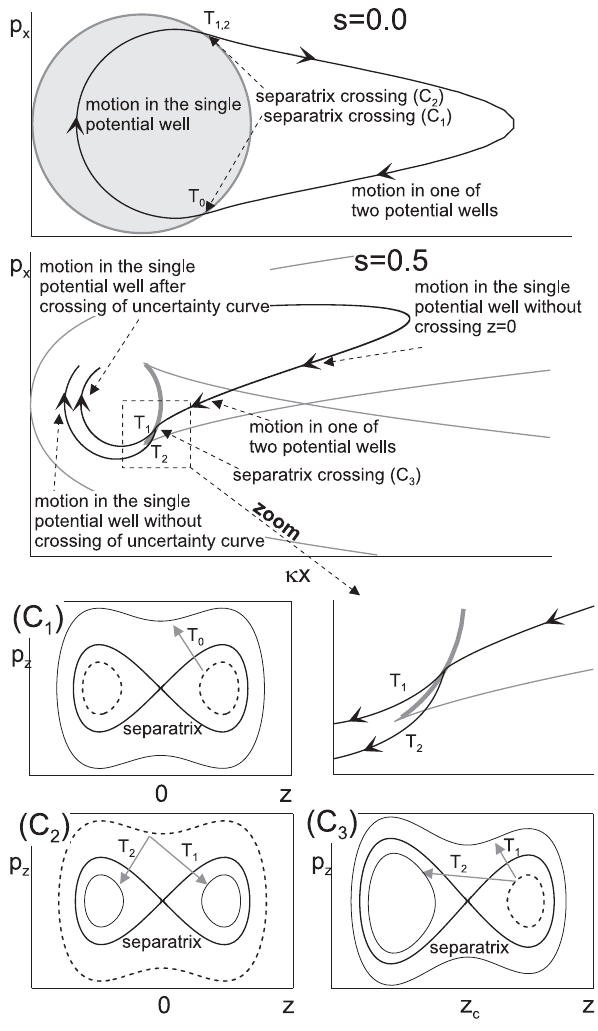
Fig. 4. Schemes of particle trajectories in systems with s = 0 and with s = 0 . 5 are shown in the phase plane (κx,p x ) . Fragment of (κx,p x ) plane with trajectory splitting is shown in separated panel. Bottom schemes (C1, C2, C3) show particle trajectories before (dot- ted curves) and after (solid curves) separatrix crossings in the plane (z,p z )